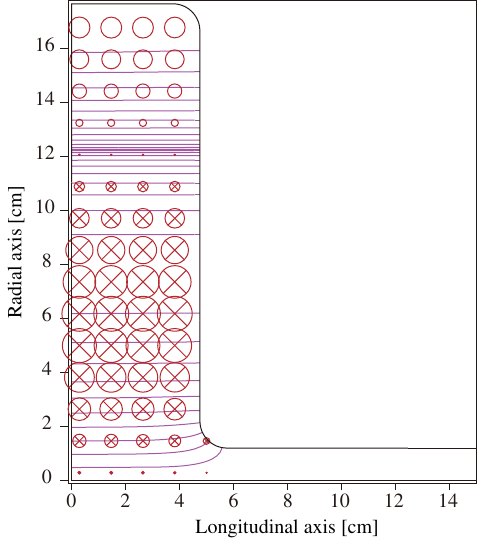
FIG. 1. Inner shape (in z - r plane) of the 1.5-GHz TM020-mode cavity. Only a half of the cavity is shown. Lines and circles indicate the electric and magnetic fields, respectively.